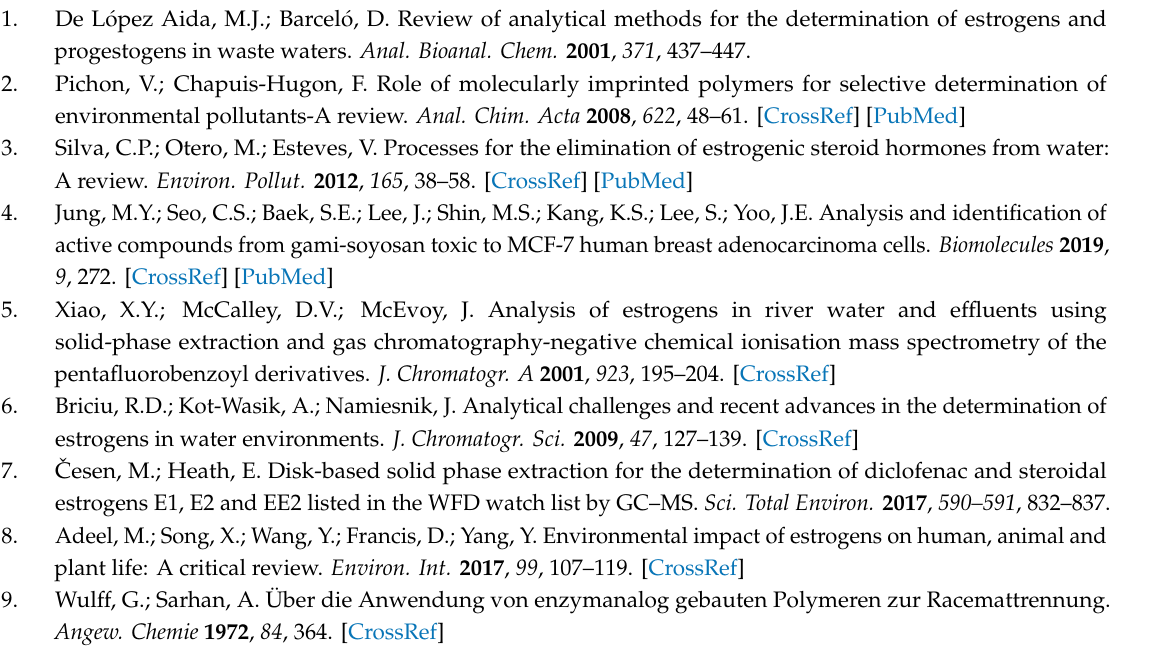
Table S1: Physicochemical properties of natural steroidal estrogens, Figure S1: The steps for the preparation of estrogens (R = O or -OH) molecularly imprinted polymers, Figure S2: SEM images of the obtained polymers, Figure S3: ESI-MS (positive ions) spectrum of E1, Figure S4: Fragmentation spectrum of the m / z 271 ion observed for E1, Figure S5: ESI-MS (positive ions) spectrum of E2, Figure S6: Fragmentation spectrum of the m / z 273 ion observed for E2, Figure S7: Dependence of signal intensity vs. estrogens concentration in the